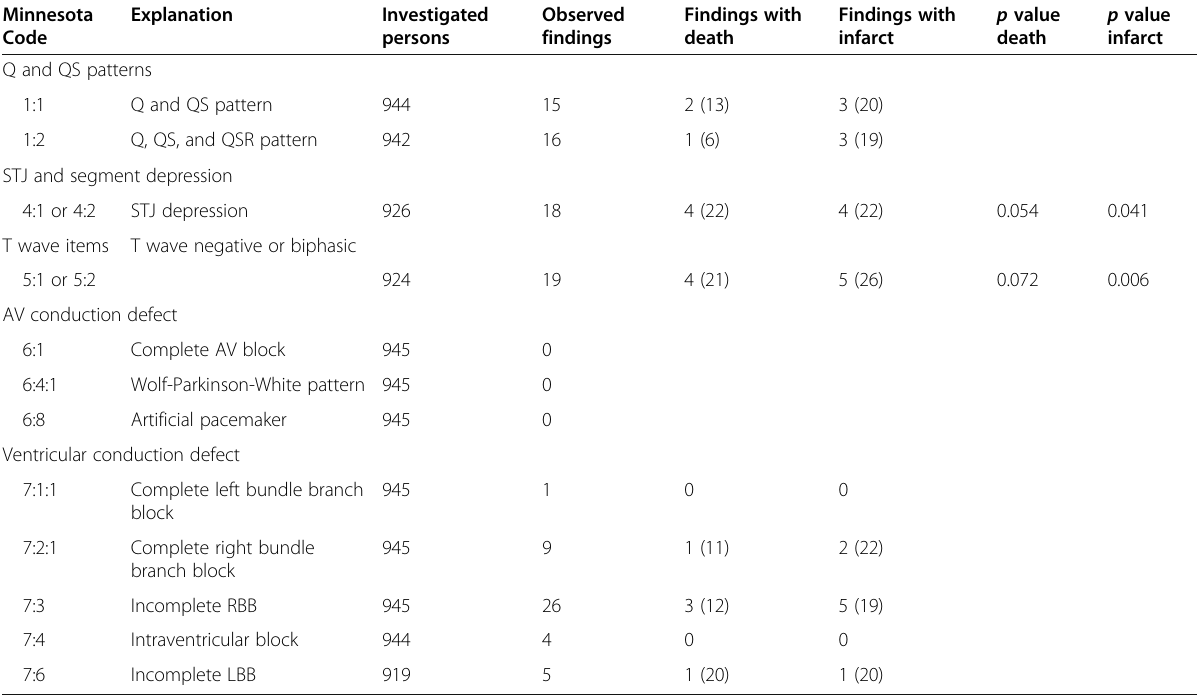
Table 9 Number of ECG deviations in 1998 follow-up